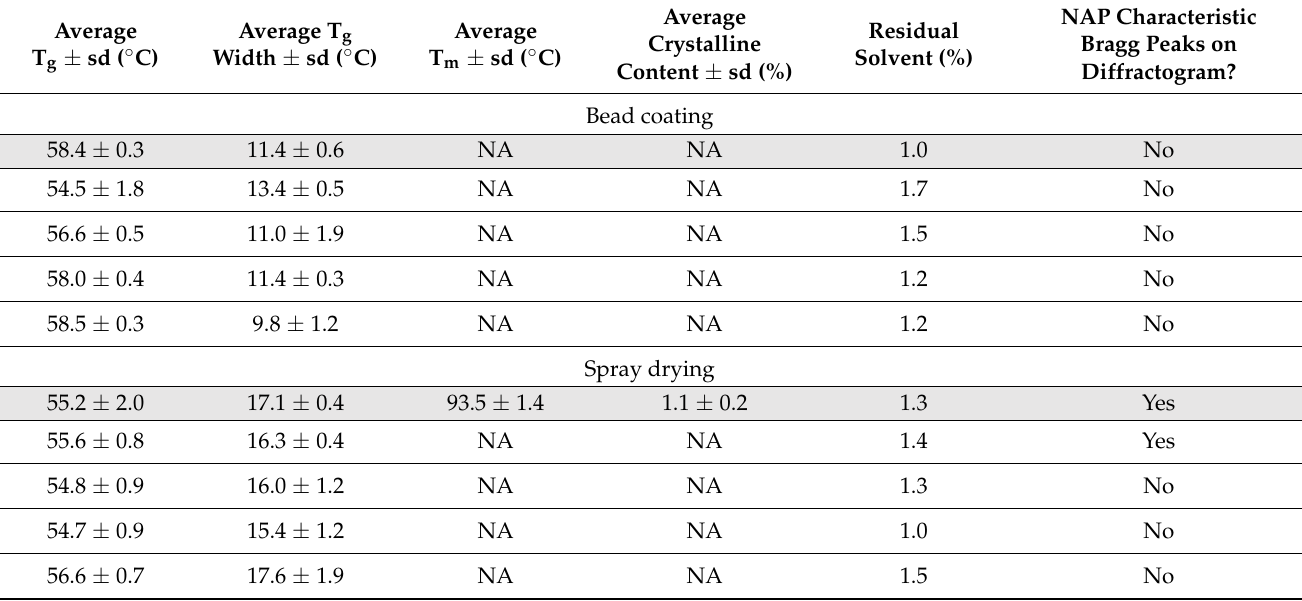
Table 4. Phase behavior of NAP–PVP-VA formulations with 40% drug load prepared with bead coating and spray drying, as part of the repeatability assessment. Average T g s, T g widths, T m values and crystallinity percentages ± sd are obtained from mDSC measurements. Residual solvent percentages are derived from TGA analyses. NA = not applicable. Data marked in light grey are the results from the initial drug loading screening (see, also, Table 2) and are shown as comparison.